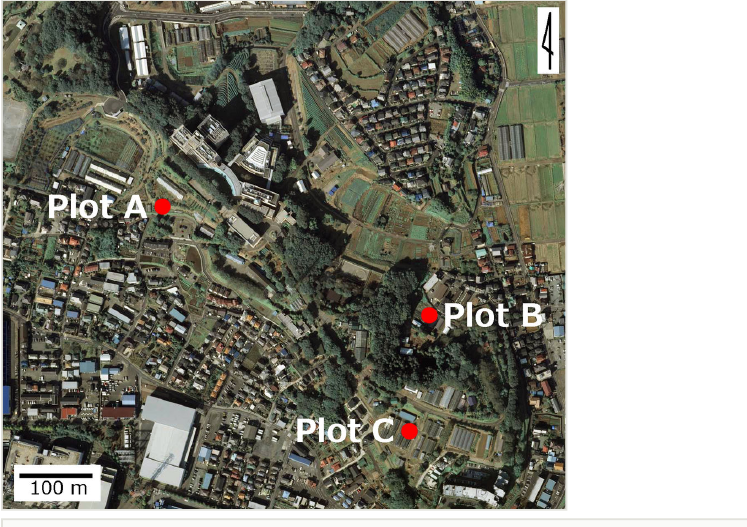
Aerial photograph of the Atsugi Campus of Tokyo University of Agriculture (TUA) and surrounding residential quarters, with locations of the three survey plots (taken in 2007 by the Geospatial Information Authority of Japan).